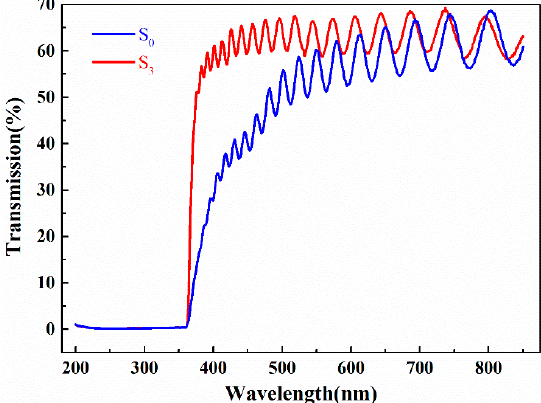
Figure 3. Optical transmission spectra of Be-implanted GaN sample unannealed (blue line) and post-implantation RTA at 1100 °C(red line).